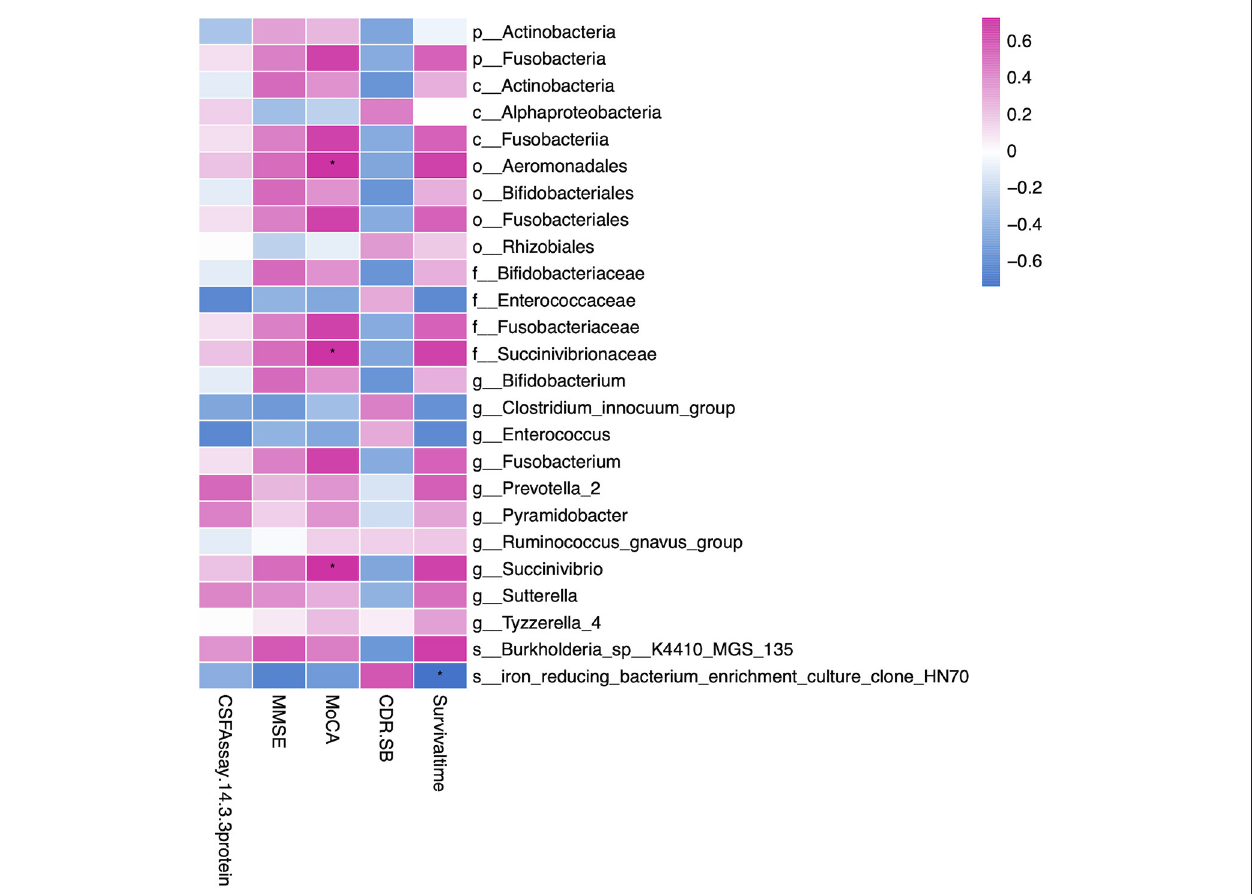
FIGURE 4 | Heatmap showing the correlation of gut microbiota and clinical profiles, namely, MMSE, MoCA, CDR-SB, CSF 14-3-3 protein, and survival time. We found order Aeromonadales, family Succinivibrionaceae, and genus Succinivibrio were positively correlated to the MoCA rating scale. In addition, iron-reducing bacterium (clone HN70) was negatively related to the patient survival time. The correlation was calculated by the Spearman algorithm, and the heatmap was drawn by the ggplot2 package in R software. Red represents a positive correlation, and blue represents a negative correlation. * Indicates the correlation is significant ( p < 0.05). MMSE, Mini-Mental State Examination; MoCA, Montreal Cognitive Assessment; CDR-SB, Clinical Dementia Rating scale Sum of Boxes; p, phylum; c, class; o, order; f, family; g, genus; s, species. * represent p value <